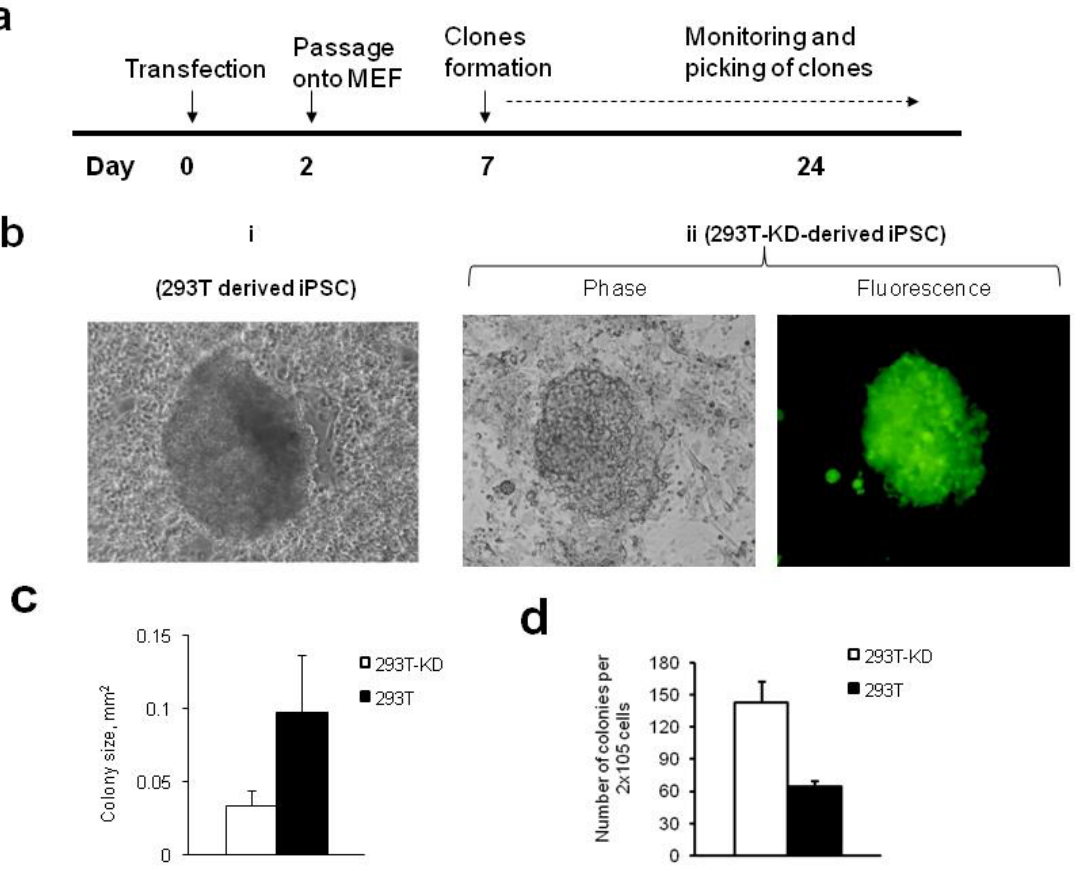
Figure 2. Generation of iPSC from 293T and 293T-KD cells. ( a ) A schematic diagram